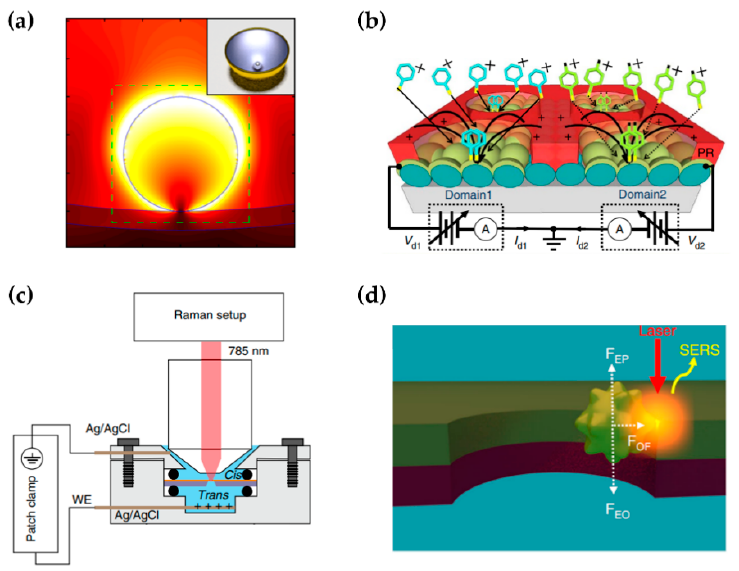
Figure 3. Strategies to improve the probability of molecules in hotspots. ( a ) FDTD simulation for a Ag nanoparticle on a warped Au substrate. Figure reproduced from [72]. Inset: the schematic of the NPoM with warped substrate. FDTD, finite difference time domain. ( b ) The SERS substrate with programmable localized electrodynamic precipitation. Figure reproduced from [73]. PR, patterned photoresist layer. ( c ) Schematic of the setup for nanoslit SERS. Figure reproduced from [15]. WE, working electrode. ( d ) Electro–plasmonic trapping due to the balance between the electrophoretic (F EP ), electroosmotic (F EO ), and plasmonic gradient force (F OF ). Figure reproduced from [74].